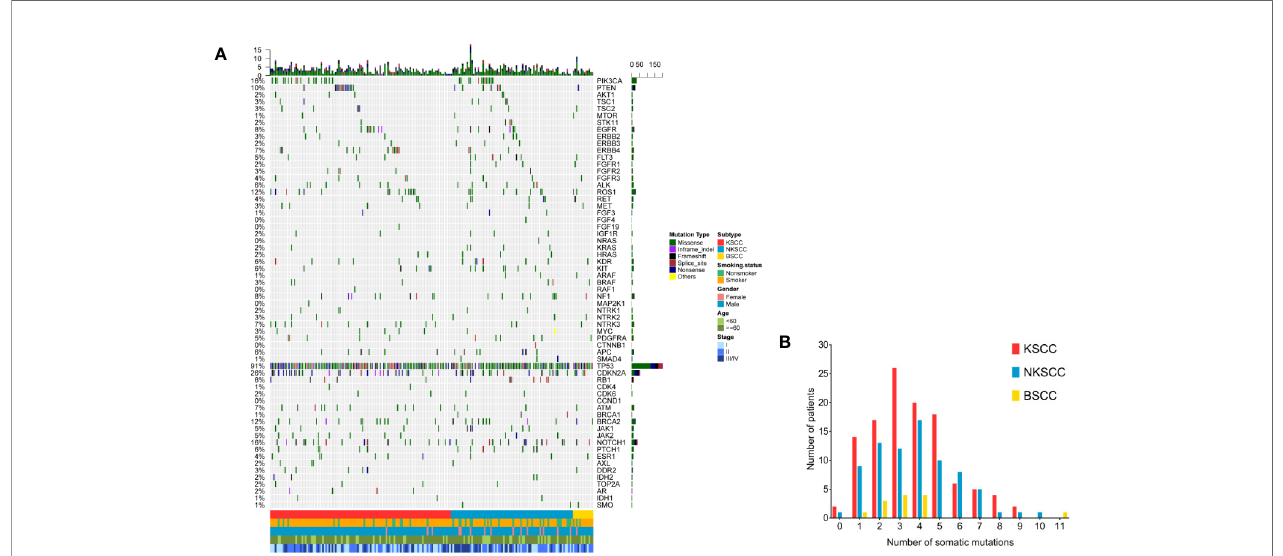
FIGURE 2 | (A) The spectra of somatic mutations of the LUSC patients grouped according to histological subtypes. Smoking status, gender, age, and disease stage were also annotated at the bottom of the oncoprint. Each column represents a patient and each row represents a gene. Column on the left represents the mutation rate of each gene. Column on the right represents mutated genes. Top plot represents the overall number of mutations a patient carried. Different colors denote different types of mutation (B) . Somatic mutation frequency of LUSC patients according to their histological subtypes. X-axis denotes number of somatic mutations, Y-axis denotes number of patients. LUSC, lung squamous cell carcinoma; KSCC, keratinizing squamous cell carcinoma; NKSCC, non-keratinizing squamous cell carcinoma; BSCC, basaloid squamous cell